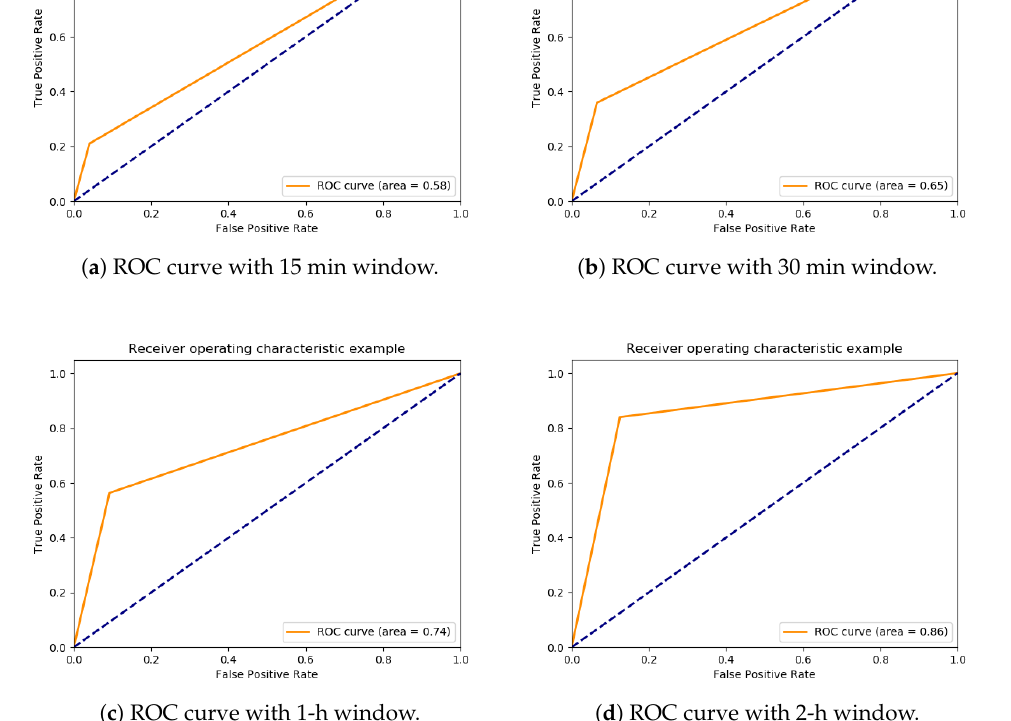
Figure 15. The deep learning model of smokers behaviour ROC